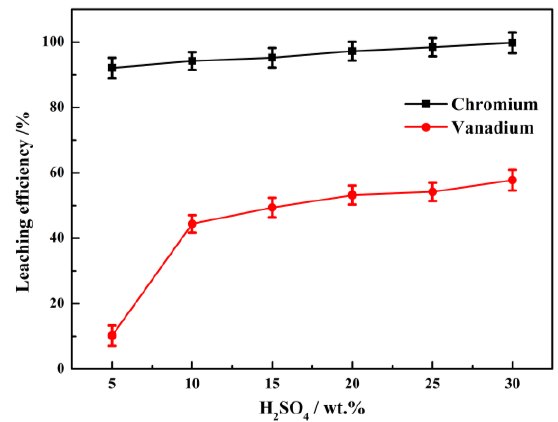
Figure 3. Effect of concentration of H 2 SO 4 on the leaching efficiency of vanadium and